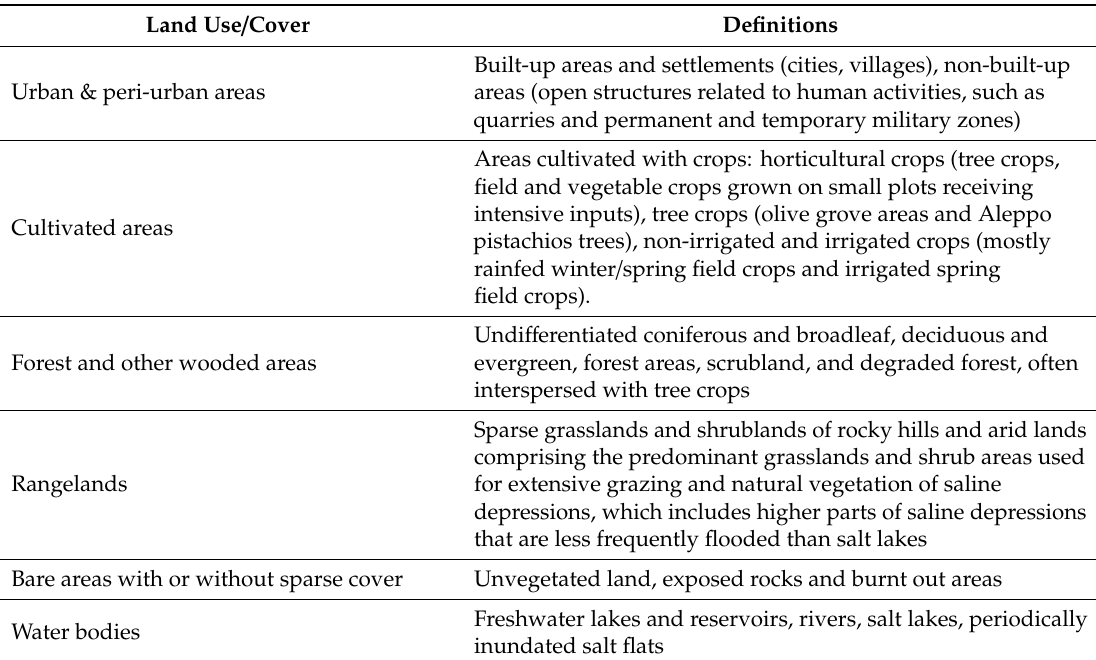
Table 3. Definitions of land use / cover classes in